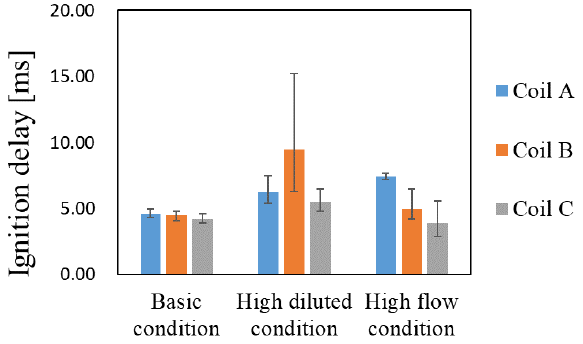
Figure 8. Ignition delay of all the conditions.